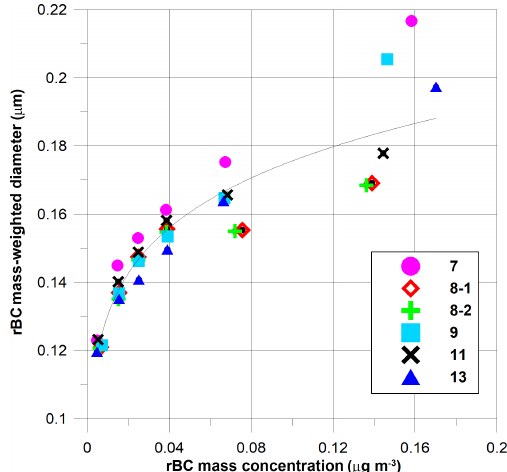
Figure 9. Mean mass-weighted diameters of rBC measurements vs. rBC mass concentrations, assuming spherical rBC components. Points are averages for mass concentration intervals of 0–0.01, 0.01–0.02, 0.02–0.03, 0.03–0.05, 0.05–0.1 and 0.1 to the maxi- mum observed. The power law fit ( y = 0 . 237 [ x 0 . 129 ] ) is through all points, with an R 2 of 0.89 and confidence level of better than 99%. The power law is appropriate based on the relationship between the diameter and mass of a sphere, which includes the diameter going to zero as the mass goes to